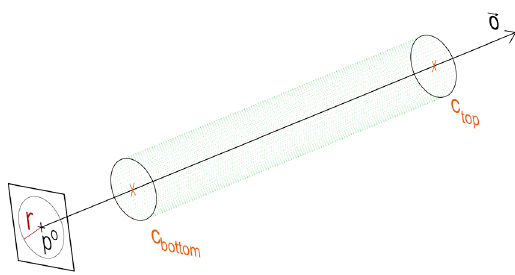
Figure 3. The parameters of the cylinder.